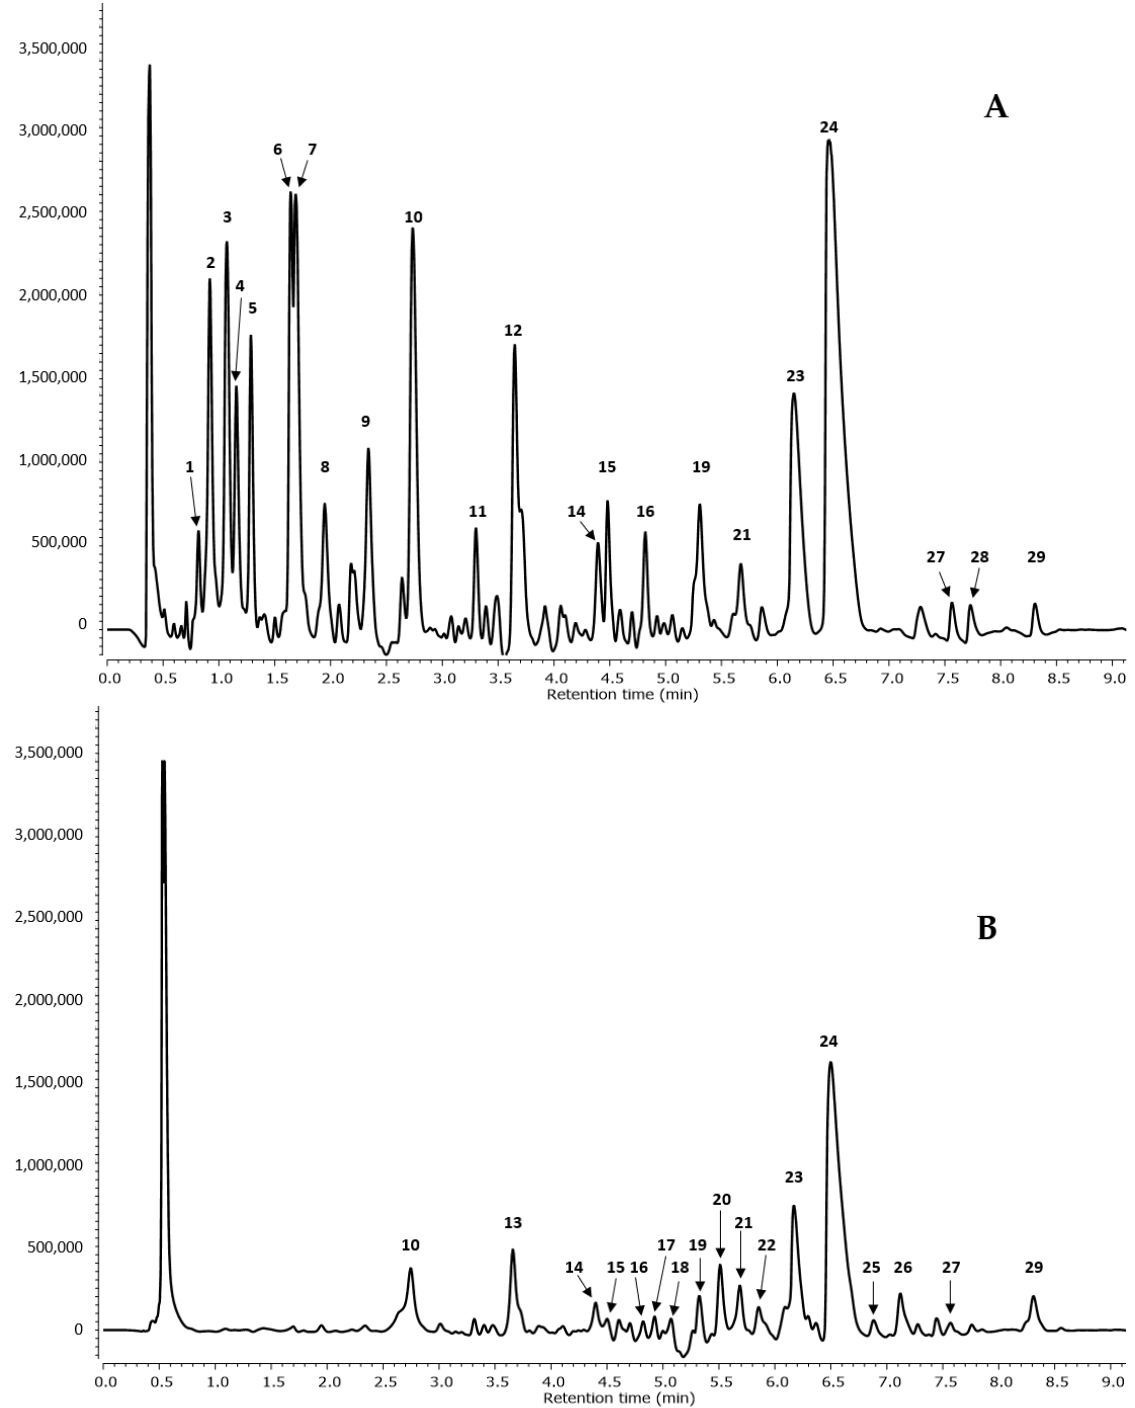
Figure 1. UPLC–MS chromatogram profile of Alder acorns ( A ) water and ( B ) ethanol extracts at 280 nm. Peak number identities are displayed in Table 1.